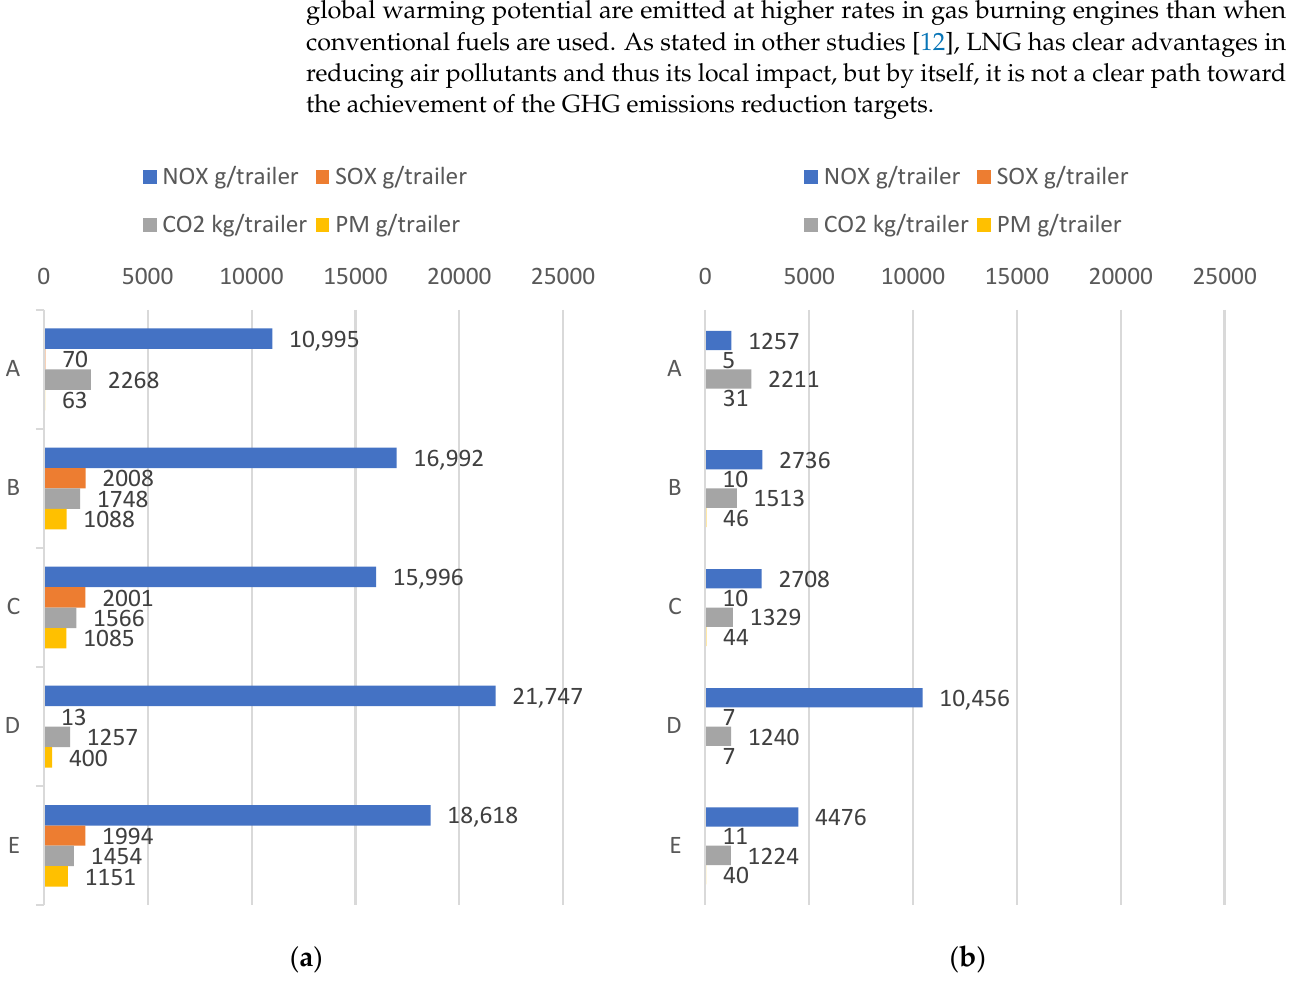
Figure 3. Emissions per trailer: ( a ) scenario 1; ( b ) scenario 2. Table 12. Emissions reduction between scenarios 1 and 2.